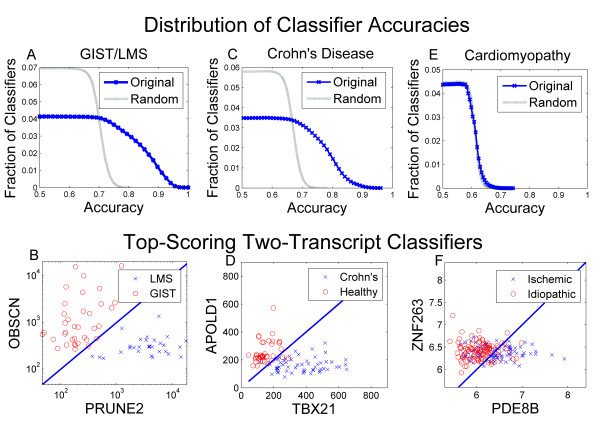
Top-Scoring Classifiers and Distributions of Classifier Accuracies. A: The distribution of all possible gene pair classifiers according to accuracy in the diagnosis of GIST and LMS, for both original data and randomly permuted data with randomized class labels. Vertical axis represents the fraction of pairs achieving the indicated accuracy. B: Plot comparing the expression level of the two genes from the top-scoring classifier as measured through a microarray platform, with a line of slope one and intercept of zero separating the two phenotypes according to the more highly expressed transcript. (Figure adapted from data originally published in [26].) C and D: Classifier accuracy distribution and top-scoring classifier microarray gene expression values for the diagnosis Crohns's Disease from circulating leukocytes. E and F: Accuracy distribution and top-scoring classifier in the diagnosis of ischemic and idiopathic cardiomyopathy.